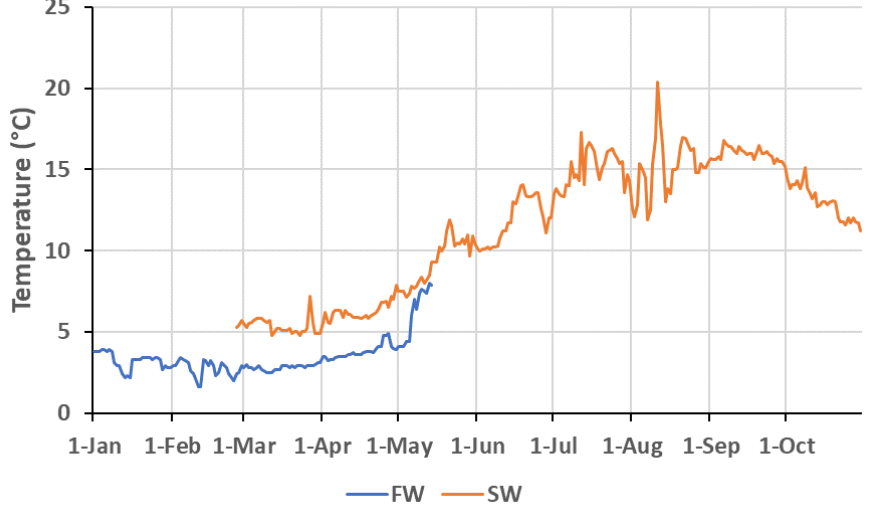
Figure 2. Temperature ( ◦ C) in freshwater (in blue) from 1 January to 15 May 2016 and in seawater (orange) from 1 March until the end of October 2016. (Martinez et al.) .